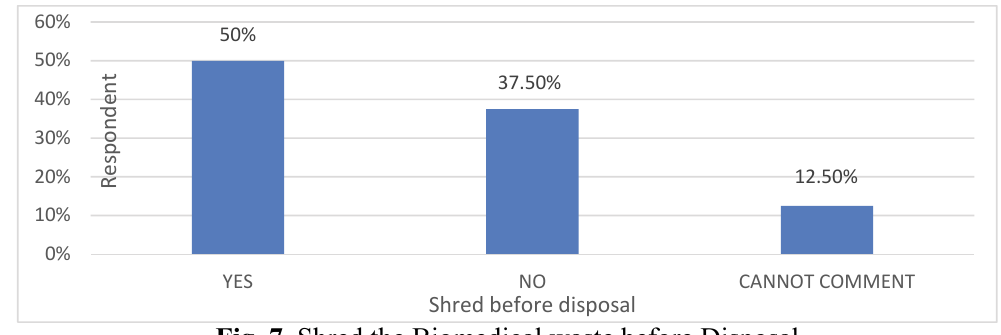
Fig. 7. Shred the Biomedical waste before Disposal